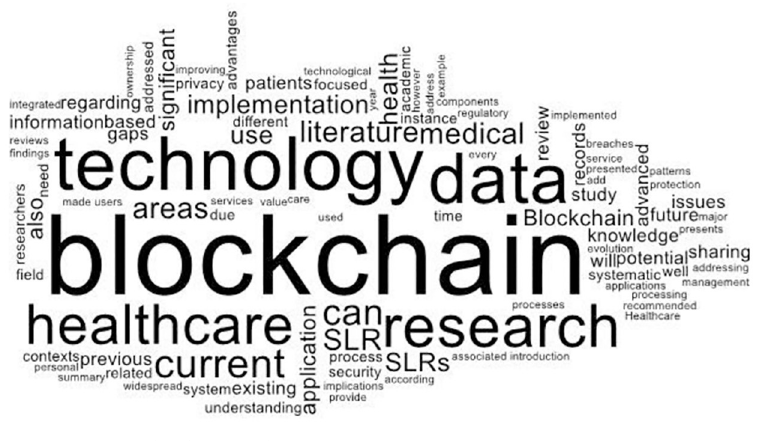
Fig 4. Constructs key